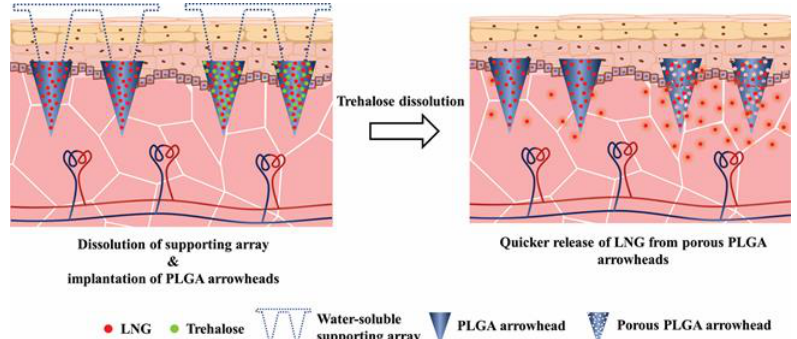
Figure 1. Schematic illustration of the release of LNG from implantable PLGA microneedles with or without trehalose.